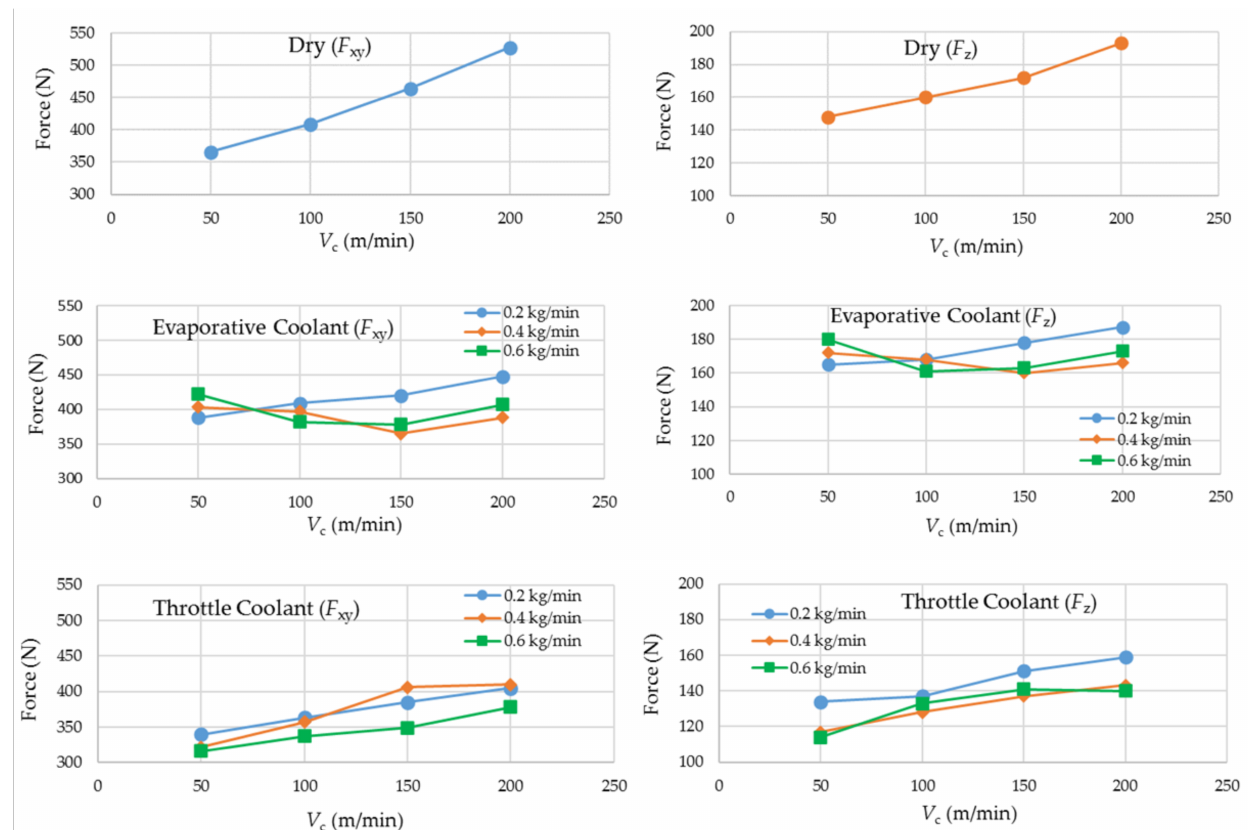
Figure 7. Experimental results regarding F xy (resultant of the coplanar components) and F z (the component acting along the tool’s